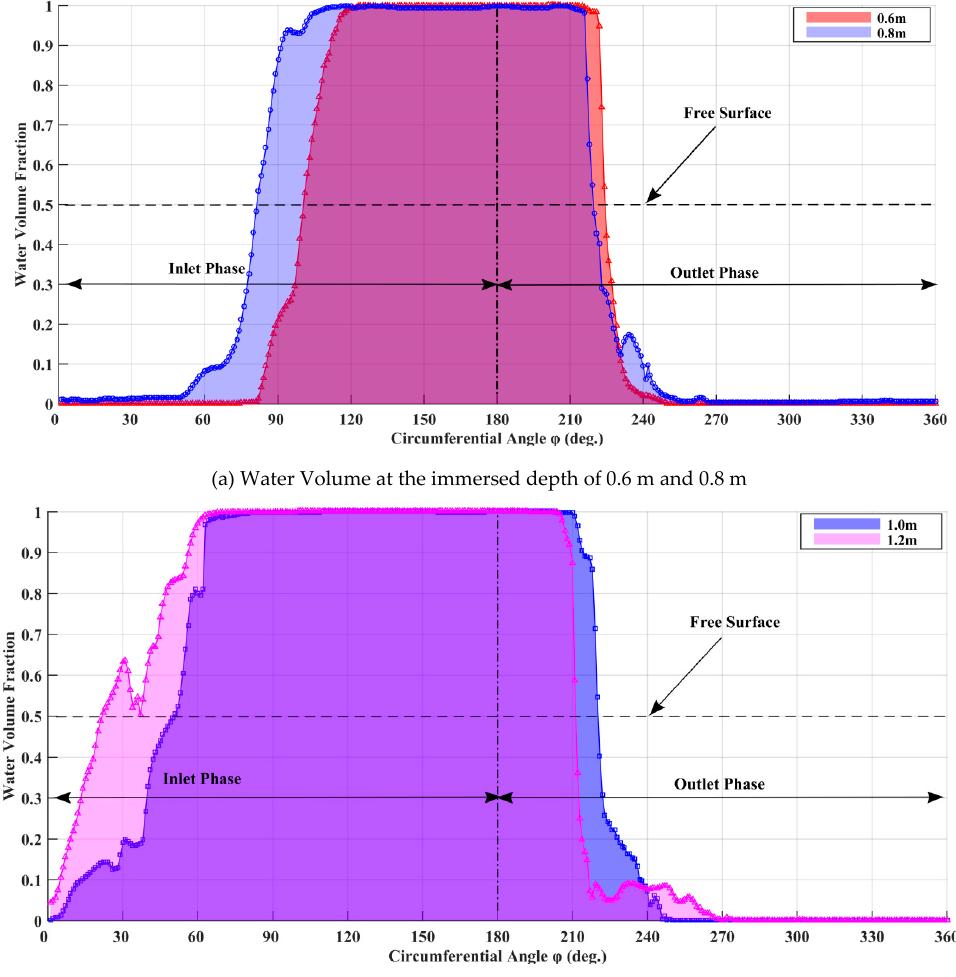
Figure 9. Water volume of different immersed depths at the wheel’s outer circumference.